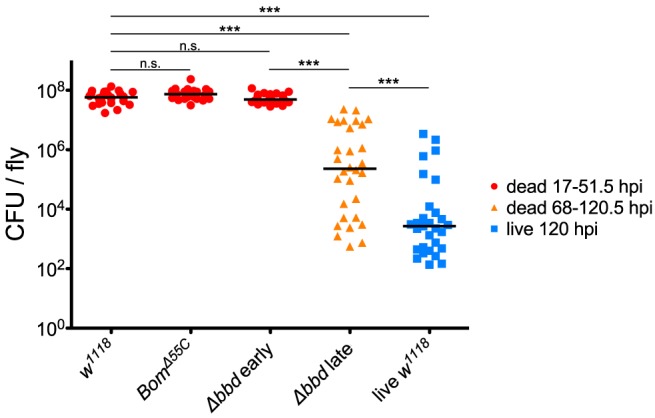
Bombardier mediates both infection resistance and tolerance. Bacterial load upon death (BLUD) of w1118, BomΔ55C, and Δbbd flies, plotted by early (17–51.5 hpi, red) or late (68–120.5 hpi, orange) time of death post-infection, as well as bacterial load of live w1118 flies 120 hpi (blue). Data was obtained and combined from three independent experiments totaling n = 26 for w1118, n = 30 for BomΔ55C, n = 33 for Δbbd red, n = 30 for Δbbd orange, and n = 29 for live w1118. Black bars indicate median values. Statistics were calculated using multiple Mann-Whitney U-tests. For significance, p = 0.0085 after Šidák correction for multiple comparisons (α = 0.05, k = 6). The pathogen loads of early deaths for BomΔ55C and Δbbd were not significantly different from w1118 (p > 0.05). The pathogen load of late Δbbd fly deaths is significantly different from that of the early-death Δbbd and w1118 groups (***p < 0.0001) and also significantly different from that of live w1118 flies 120 hpi (***p < 0.0001). Finally, the early-death w1118 pathogen load was significantly different from that of live w1118 flies 120 hpi (***p < 0.0001) (hpi, hours post-infection).